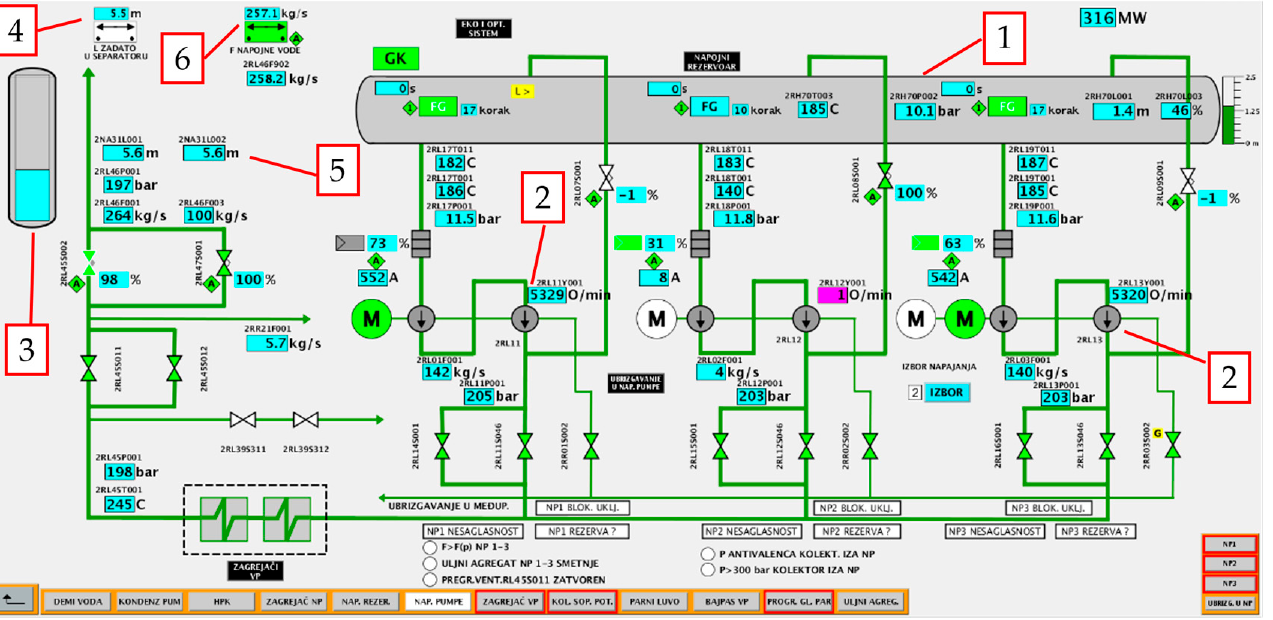
Figure 2. TE Kostolac B2 Unit, 350 MW nominal electric power—SCADA view of feedwater subsystem. 1—feedwater tank, 2—feedwater pumps, 3—steam separator (drum), 4—setpoint of water level, 5—measured water level in steam drum (separator), 6—calculated value (control variable) of feedwater flow from main PID controller.